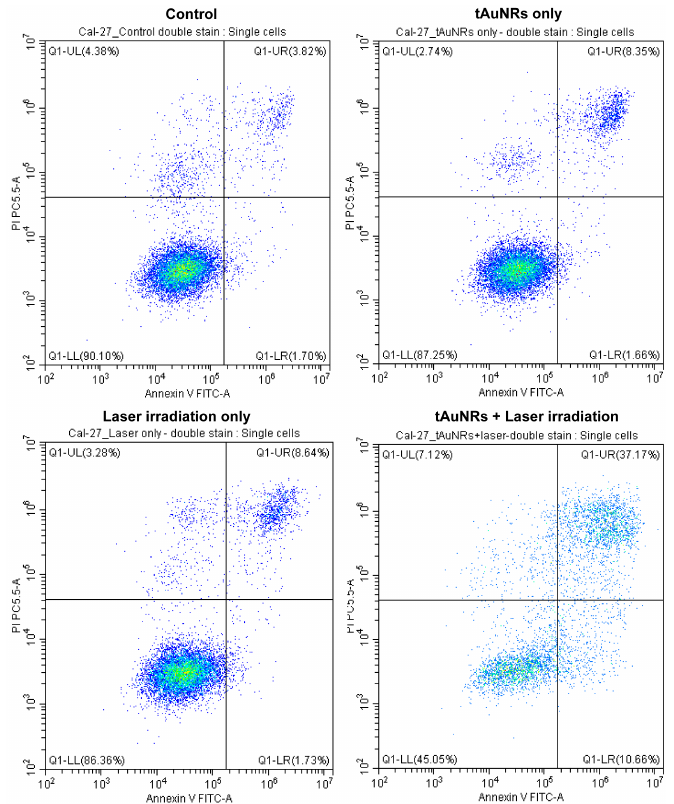
Figure 7. Apoptotic cell death in CAL-27 cells following tAuNR and laser treatment. Cells were incubated with tAuNRs alone, with laser irradiation alone or with their combination (tAuNRs + laser irradiation). Flow cytometry analysis of these cells stained with annexin V FITC and PI alongside untreated (control) cells is shown. Gating was determined based on the control cells and used for the treatment groups to determine the percentage of healthy cells (Q1-LL), cells in early apoptosis (annexin-V-positive, PI-negative, Q1-LR), cells in late apoptosis (annexin-V-positive, PI-positive, Q1-UR) and the percentage of cells undergoing necrosis (PI-positive, annexin-V-negative, Q1-UL). Total number of single cell events: control, 10,728; tAuNRs, 10,890; laser only, 10,988 and tAuNRs + laser, 4,899.